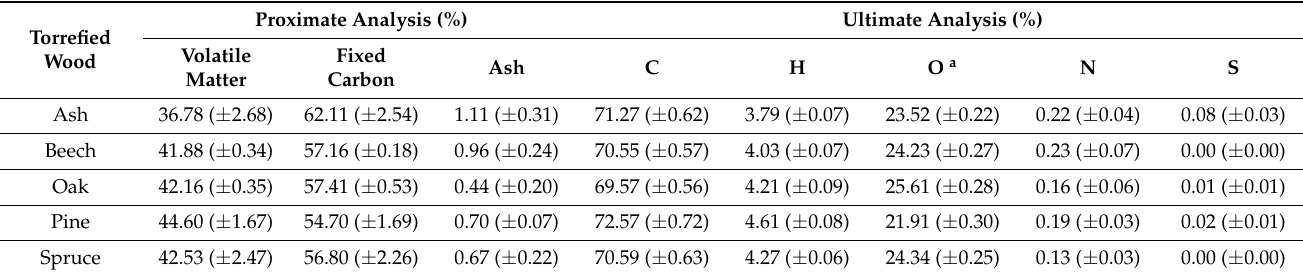
Table 2. Proximate and ultimate analysis of torrefied wood